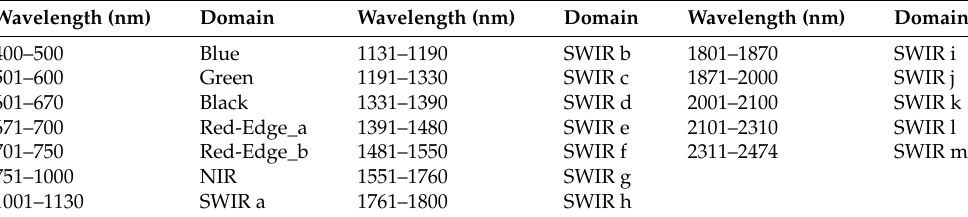
Figure 11. Vine spectral signature in the visible (VIS) to short-wave infrared (SWIR) wavelengths, with the 19 selected domains separated by dotted lines. Water and atmospheric absorption are high- lighted over the spectrum. Sentinel-2 spectral and spatial resolution are reported above the spectrum. Table 6. Correspondence between wavelengths and domains used in this study. NIR—Near